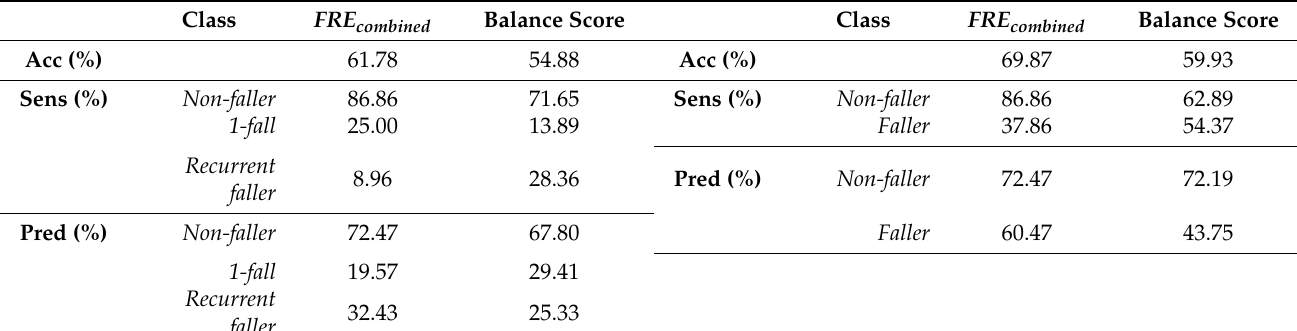
Table 2. Classification performance results for classifying FRE combined and balance score according to falls history. Results are reported for both binary and 3-class falls history. Accuracy (Acc), Sensitivity (Sens) and Predictivity (Pred) are